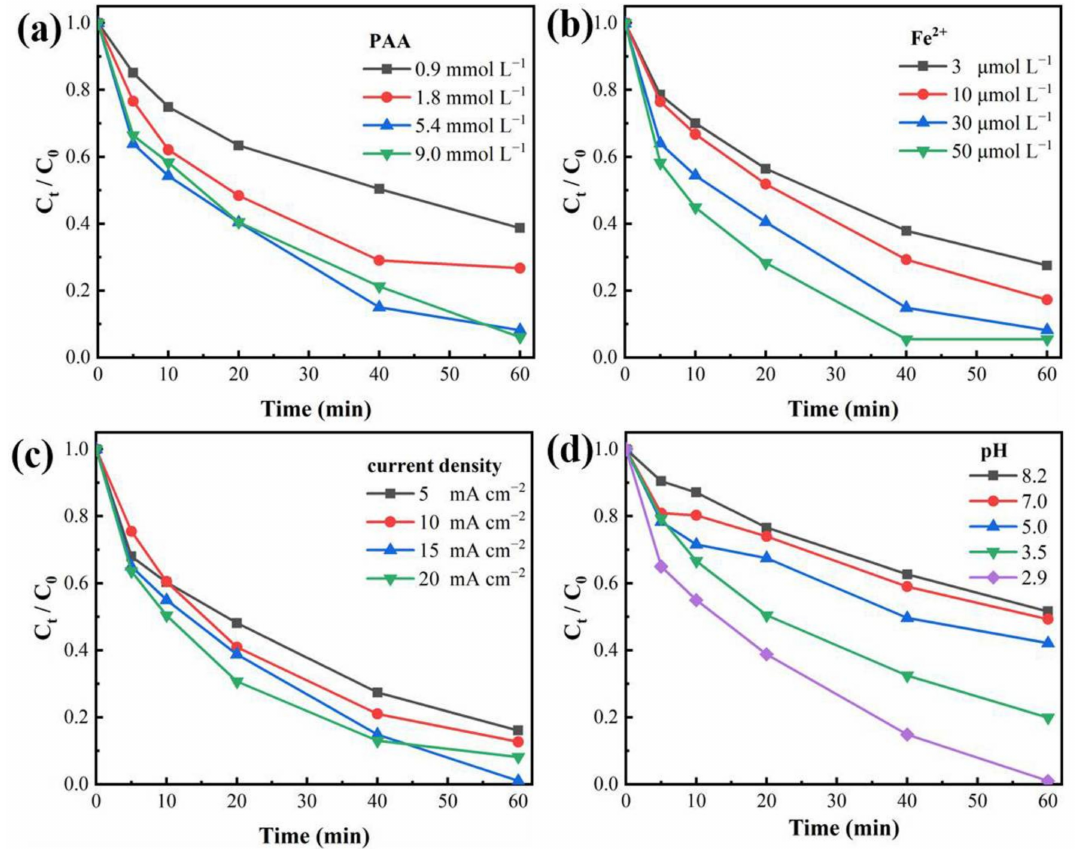
Figure 2. Decolorization ratio of MB under different reaction conditions: ( a ) PAA dosage, ( b ) Fe 2+ dosage, ( c ) current density, and ( d ) solution pH. Experimental conditions: [MB] 0 = 20 mg L − 1 , [Fe 2+ ] 0 = 30 µ mol L − 1 , [PAA] 0 = 5.4 mmol L − 1 , [H 2 O 2 ] 0 = 11.25 mmol L − 1 , [NaNO 3 ] = 30 mmol L − 1 , pH = 2.9, j = 15 mA cm − 2